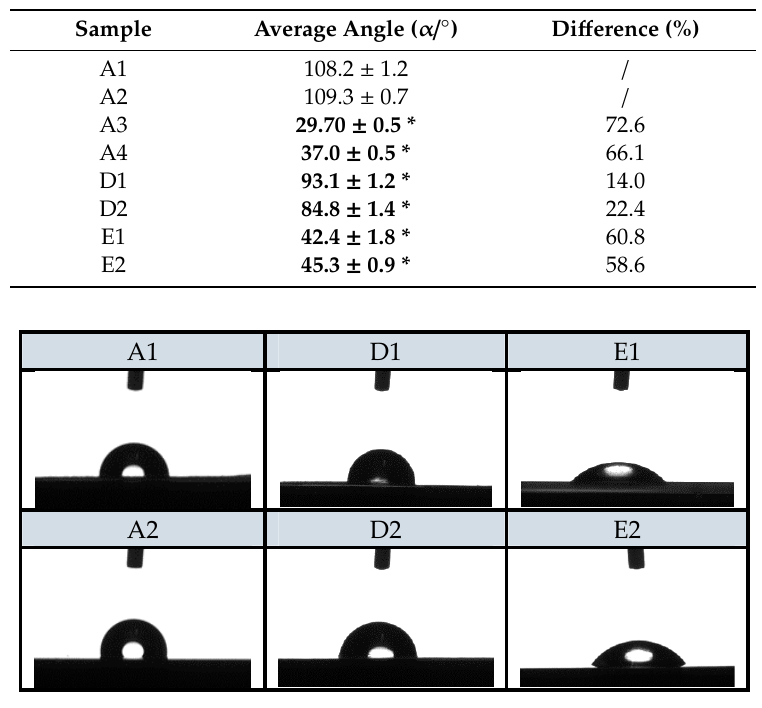
Table 8. Values of static contact angle (SCA) measurements. Statistical significance is defined as * P < 0.05 compared to control sample (ANOVA) test).